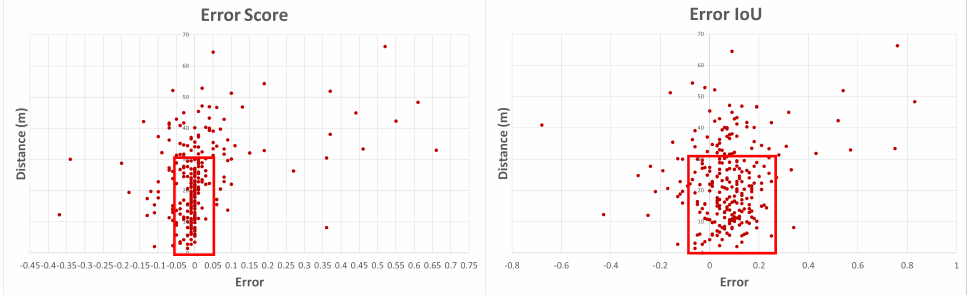
Figure 17. Error between SW-only model version and quantized backbone convolution weights, classification score, and IoU